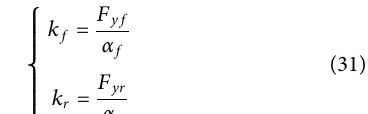
FIGURE 6 Structure of control